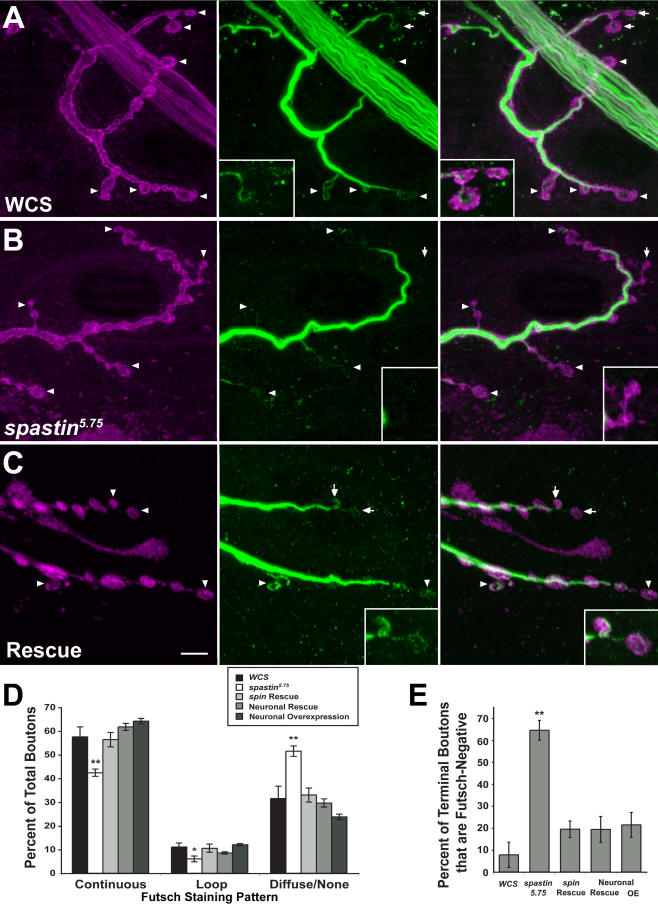
The Distribution of Stable NMJ Microtubule Bundles Marked by the MAP1B-like Protein Futsch Is Altered in spastin Mutant Larvae(A–C) Anti-Futsch labels stable microtubule bundles in axons, NMJ boutons, and interbouton regions. The muscle 4 NMJs in segment A3 of third instar wild-type (A), spastin5.75 (B), and spin-GAL4/UAS-spastin; spastin5.75 (Rescue) (C) larvae were immunostained with anti-HRP (A and B) or anti-Syt antibodies (C) to label presynaptic boutons (magenta), and mAb 22C10 to label Futsch protein (A–C, green). Arrows and arrowheads mark the terminal boutons (those at the ends of synaptic branches); boutons marked by arrows in (A–C) are enlarged in insets in the middle and right panels to show examples of Futsch patterns. (A) In control (WCS) larvae, terminal boutons have both looped (arrowheads) and diffuse, punctate (right panel, arrows and inset) patterns of Futsch staining. (B) In spastin mutants, Futsch staining appears similarly strong in axon bundles (not shown) and along the main branches of the bouton arbor. More distal and terminal boutons, however, have diffuse or no Futsch staining (arrows and arrowheads). Note the absence of green staining in insets. (C) The distribution of Futsch staining is restored to the control pattern by spin-GAL4-driven expression of Spastin in the mutant background (arrows and arrowheads indicate loops). Scale bar, 5 μm.(D and E) Quantitative assessment of Futsch staining data. Futsch staining at A2 and A3 muscle 4 NMJs was classified as continuous (bundles or splayed bundles), looped, or diffuse or undetectable (none) for each bouton. (D) The percentage of boutons exhibiting continuous or looped Futsch staining (relative to the total number of boutons for each NMJ) is decreased in spastin mutants relative to controls, while the percentage of boutons having diffuse or no staining is increased. In total, 58% ± 4.2% of boutons in controls have a continuous pattern of Futsch staining, while only 42% ± 1.5% do in mutants. Boutons in this class are predominantly along the major (more proximal) branches of the axon arbor. Similarly, 11% ± 1.7% of wild-type boutons have Futsch loops, but only 6.0% ± 1.1% do in mutants. Most mutant boutons show only diffuse or no Futsch staining (52% ± 2.2%, versus 32% ± 5.2% in controls). Futsch distribution is restored to the control pattern by spin-GAL4- or Elav-GS-GAL4-driven expression of Spastin. (E) The difference in Futsch distribution is most pronounced at terminal boutons. There is no detectable Futsch staining in the majority of terminal boutons (65% ± 4.5%) in spastin mutants, compared to only 7.8% ± 5.8% of terminal boutons in wild-type larvae (p < 2 × 10−6). Futsch staining is restored in most terminal boutons of spin-GAL4- or Elav-GS-GAL4-rescued larvae, with only 20% ± 3.7% and 19% ± 5.9% of boutons, respectively, showing no staining (p = 0.09 compared to WCS). Terminal bouton staining in larvae overexpressing Spastin in neurons was unaffected relative to controls (p = 0.12). **, p < 0.005; *, p < 0.03 relative to WCS;
n
>8 NMJs scored in all cases.